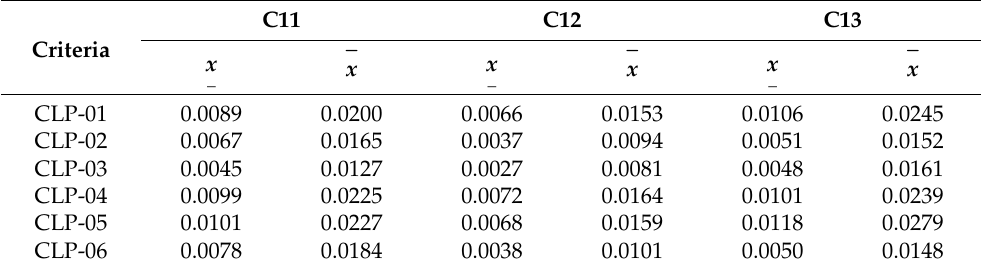
Table 13. The weighted normalized grey decision matrix of C1 (environmental).